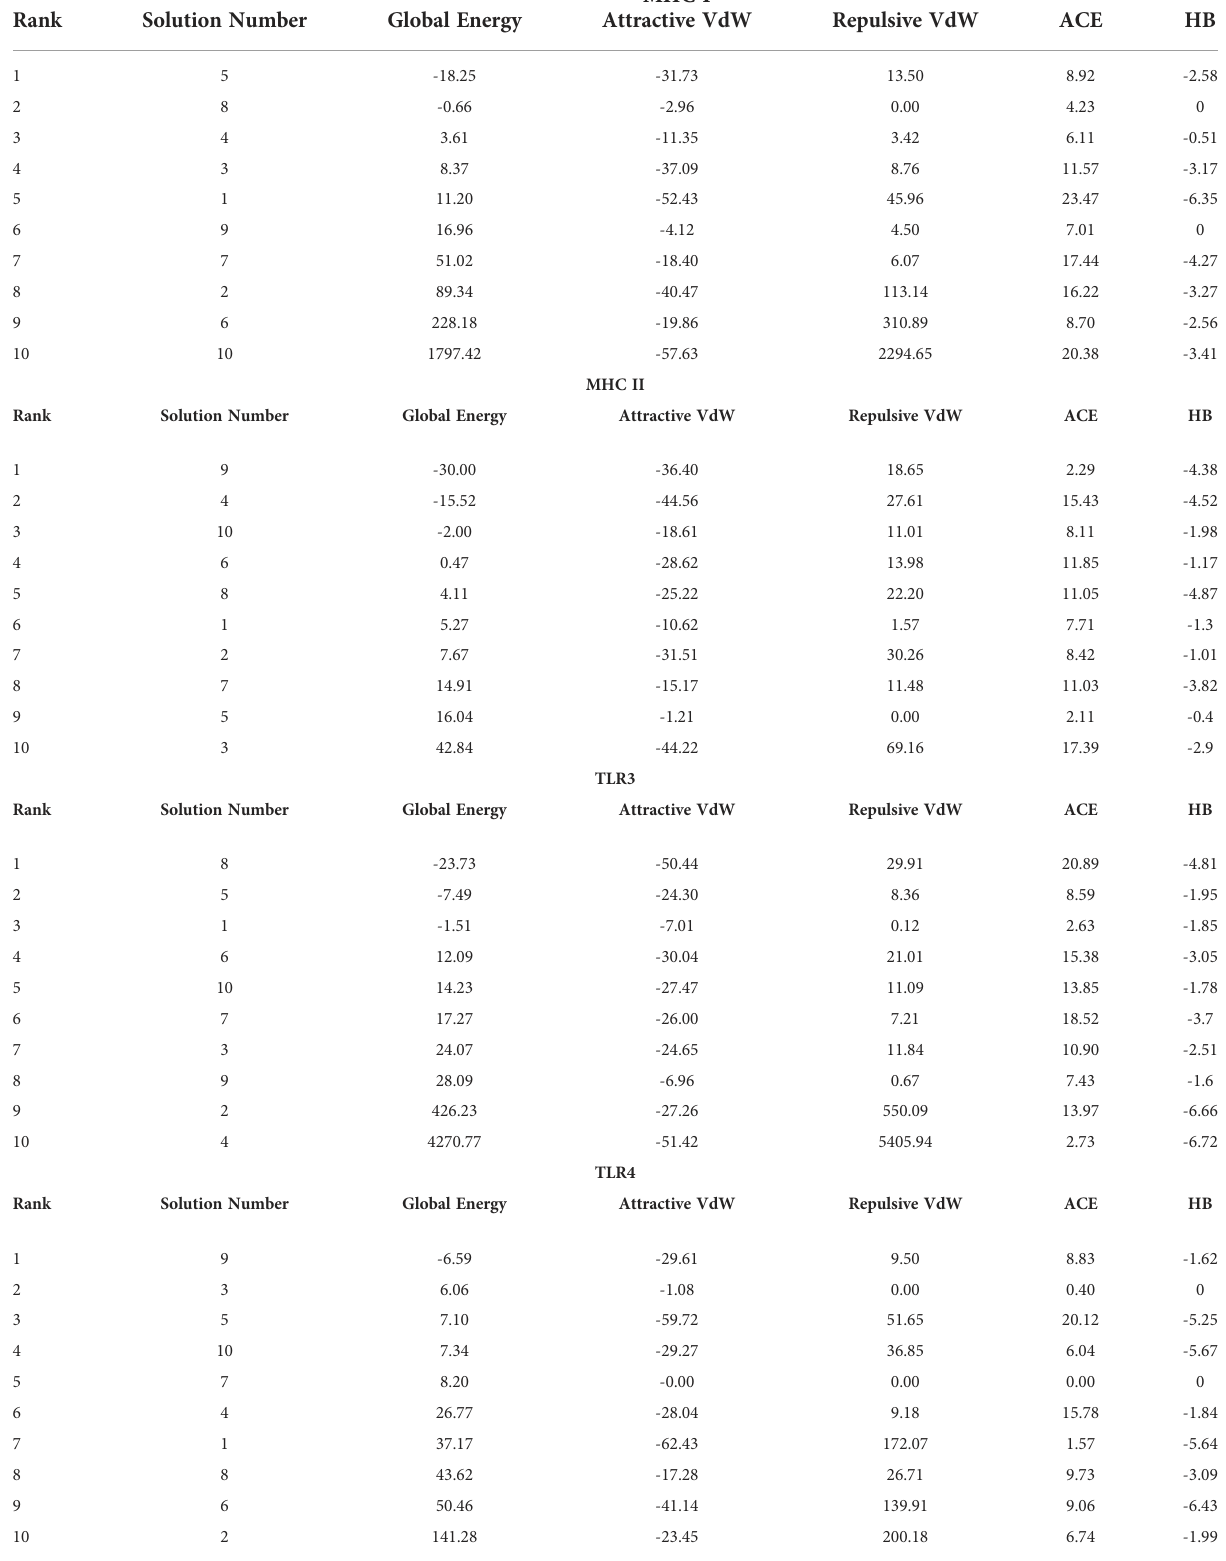
TABLE 4 Molecular docking results of MEMPV with MHC I, MHC II, TLR3 and TLR4